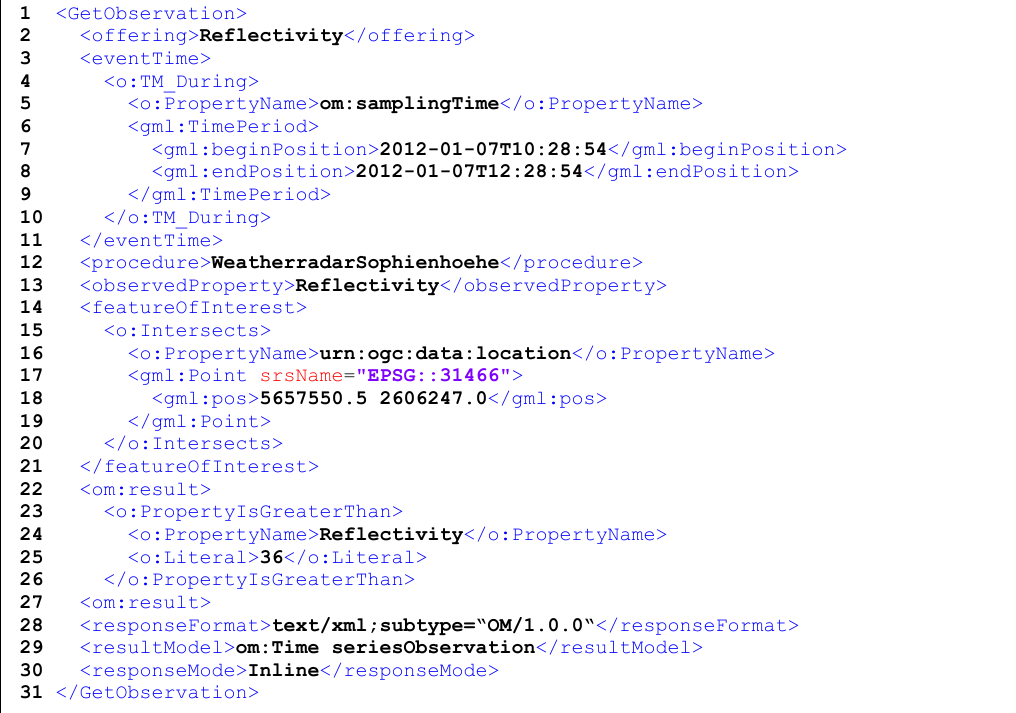
Figure 1. An SOS GetObservation request with all available